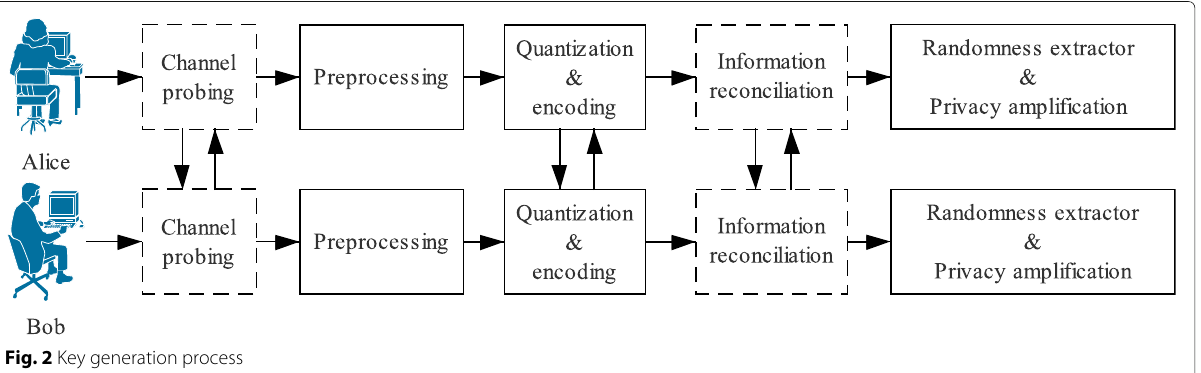
noise and f ( t ) is an instrumental signal. Therefore, the threshold value of noise in the wavelet domain can be eliminated by evaluating the wavelet coefficient or the original signal. The threshold selection rule we adopt is rigrusre. The specific steps of this method are as follows: original signal s ( t ) , sort it from small to large, and